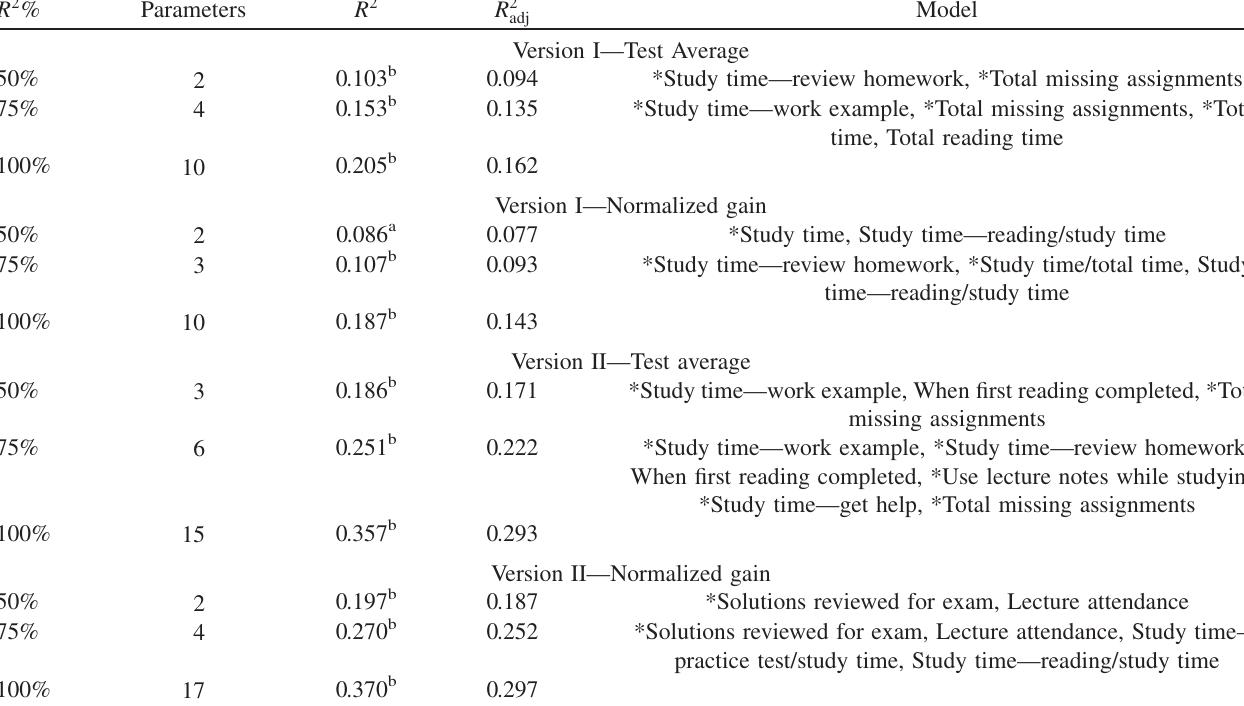
USING TIME-ON-TASK MEASUREMENTS TO . . TABLE VI. Variance in test average and normalized gain explained by behavior. For each version and for the test average and normalized gain, the last model reported is the model that maximizes R 2 this maximal model. Entries marked with ‘‘*’’ have negative coefficients.